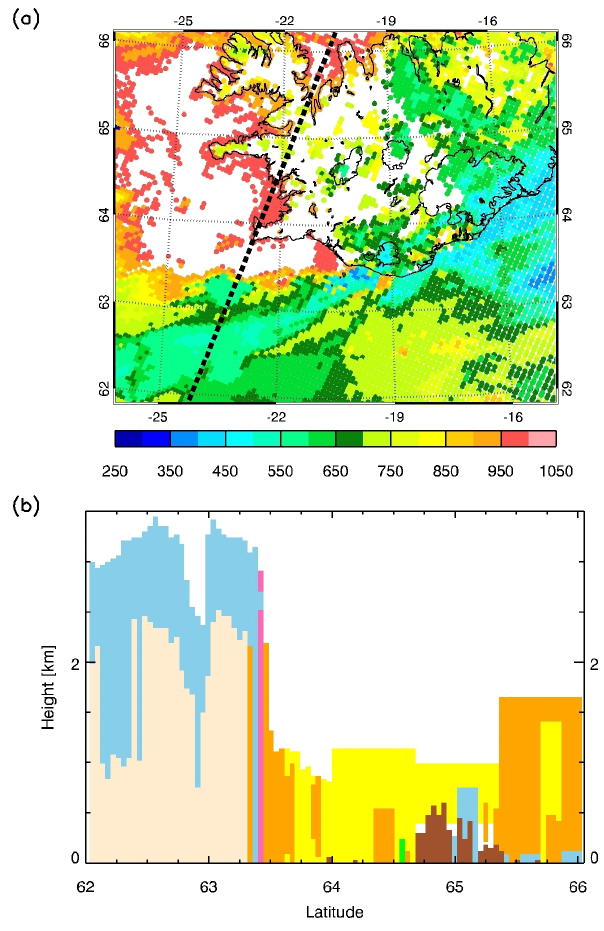
Fig. 17. Satellite observations on 21 February by CALIOP at 04:15UTC and MODIS Aqua at 04:20UTC. Panel (a) shows the CALIPSO track (black dotted line), plotted on top of MODIS cloud top pressure [hPa] (colored shadings). Panel (b) shows the verti- cal profile of aerosol type from CALIOP (white – clear air, blue – cloud, beige – no signal, brown – surface, green – clean continental, yellow – dust, orange – polluted dust, pink – clean